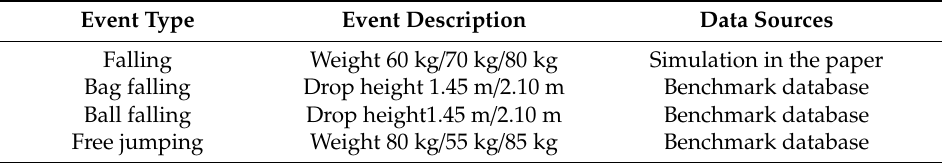
Table 8. Data structure of fall recognition database used for